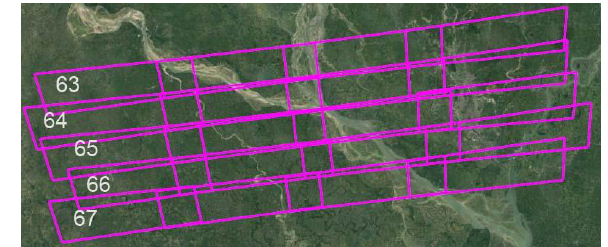
Figure 20. Footprints of neighboured CORONA afterward